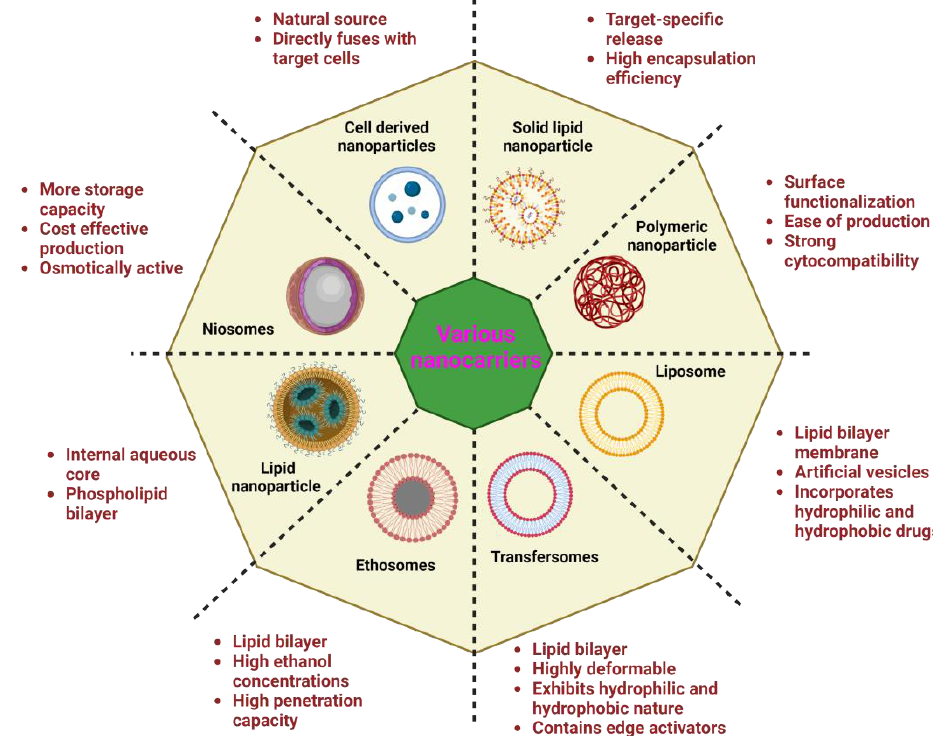
Figure 3. Types of nanocarriers with their characteristics. Created with BioRender.com accessed on 24 January